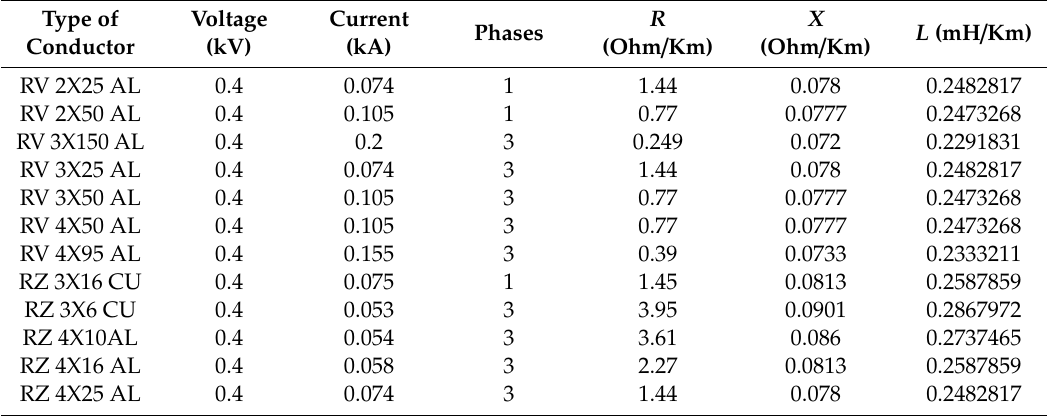
Table A1. Type of conductors